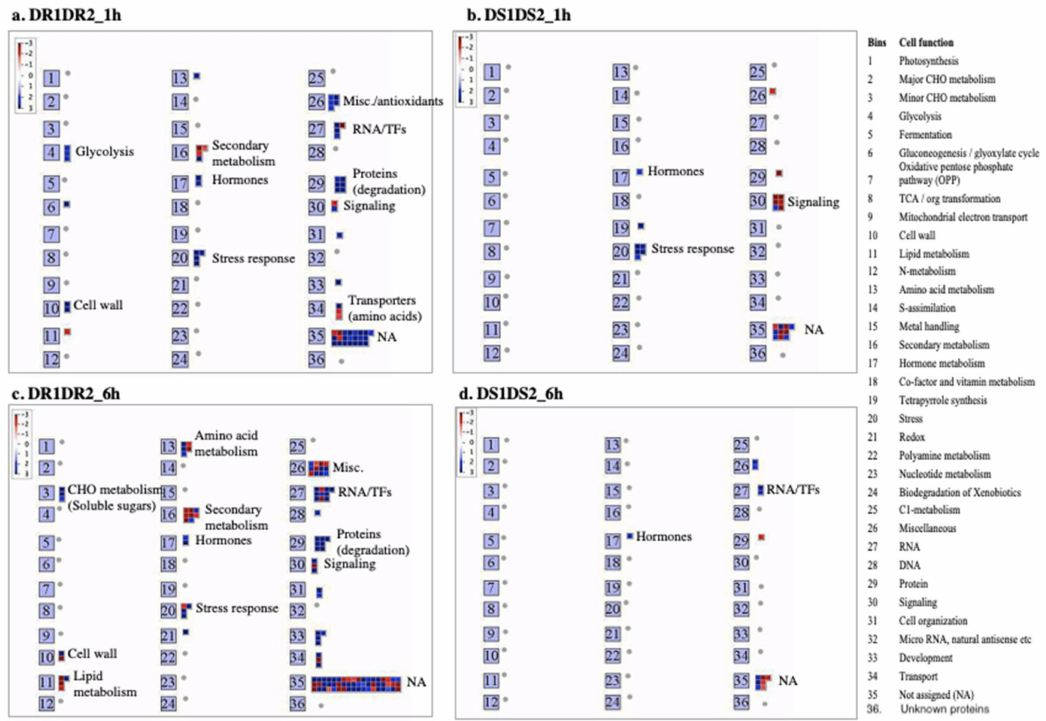
Figure 6. Functional categories of DE genes expressed only in drought-resistant (DR1 and DR2) and drought-sensitive (DS1 and DS2) sorghum genotypes at 1 h ( a , b ) and 6 h ( c , d ) of post PEG-treatment. Blue represents up-regulated and red represents down-regulated genes. This figure was generated using MapMan and show DE genes that passed the cut-o ff value of Log 2 FC ≥ 2 and ≤− 2 and q -value < 0.05. NA, Not